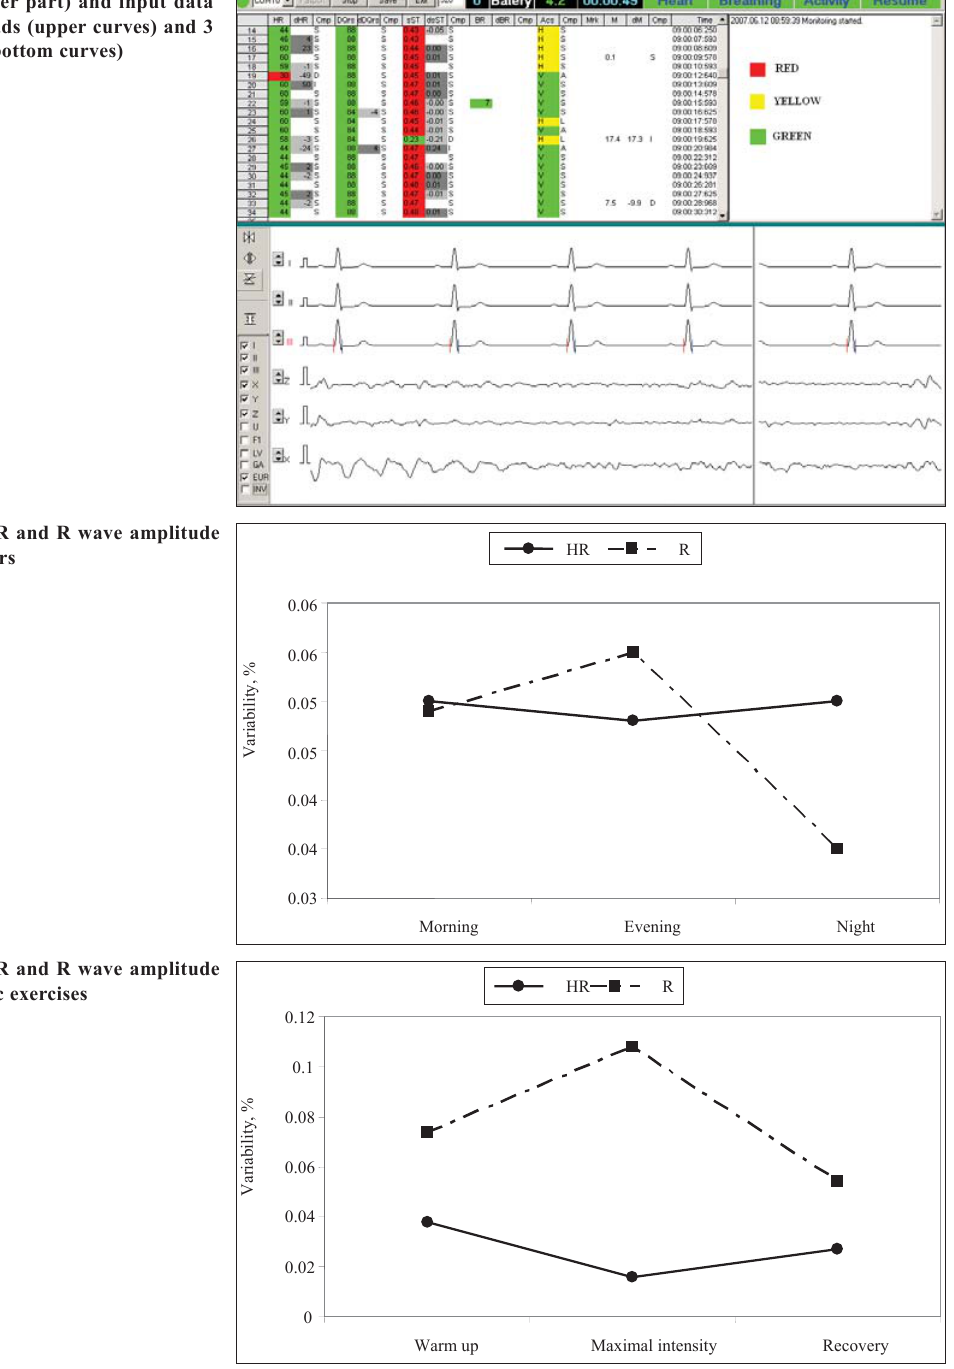
Figure 3. The sample of screenshot: table of cal- culated parameters (upper part) and input data (bottom part), 3 ECG leads (upper curves) and 3 channel motion signals (bottom curves)